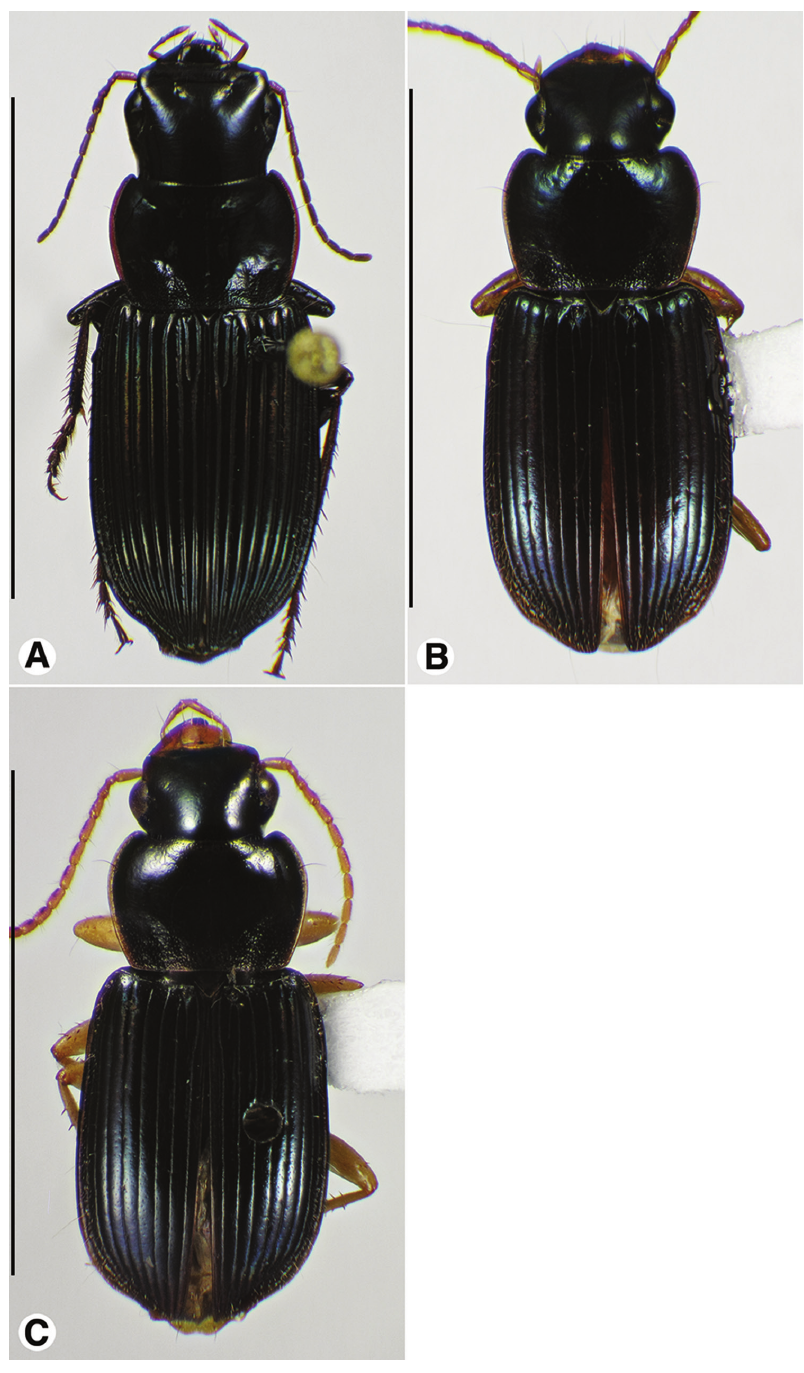
Figure 5. Habitus digital images of Amblygnathus species, dorsal aspect. A A. cephalotes Dejean B A. puncticollis (Putzeys) C A. gilvipes gilvipes Ball & Maddison. Scale bars: A 10 mm; B–C 5